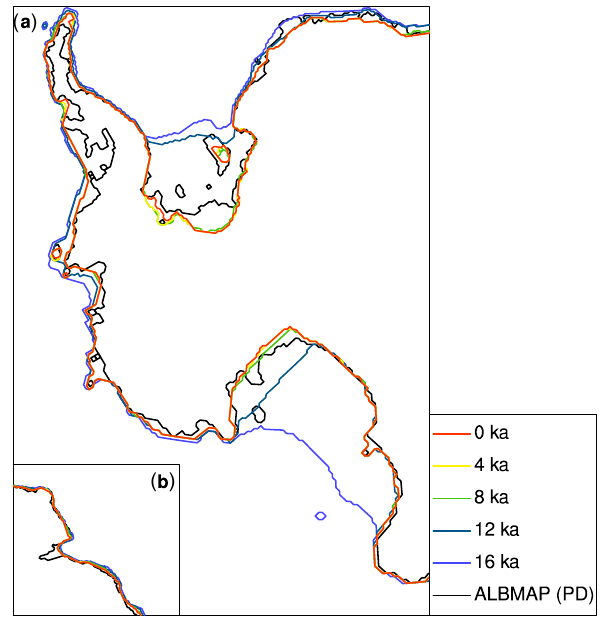
Figure 7. Grounding-line retreat from 16ka until the PD, with in black the PD grounding line from ALBMAP in (a) West Antarctica and (b) Prydz Bay (the Amery Ice Shelf